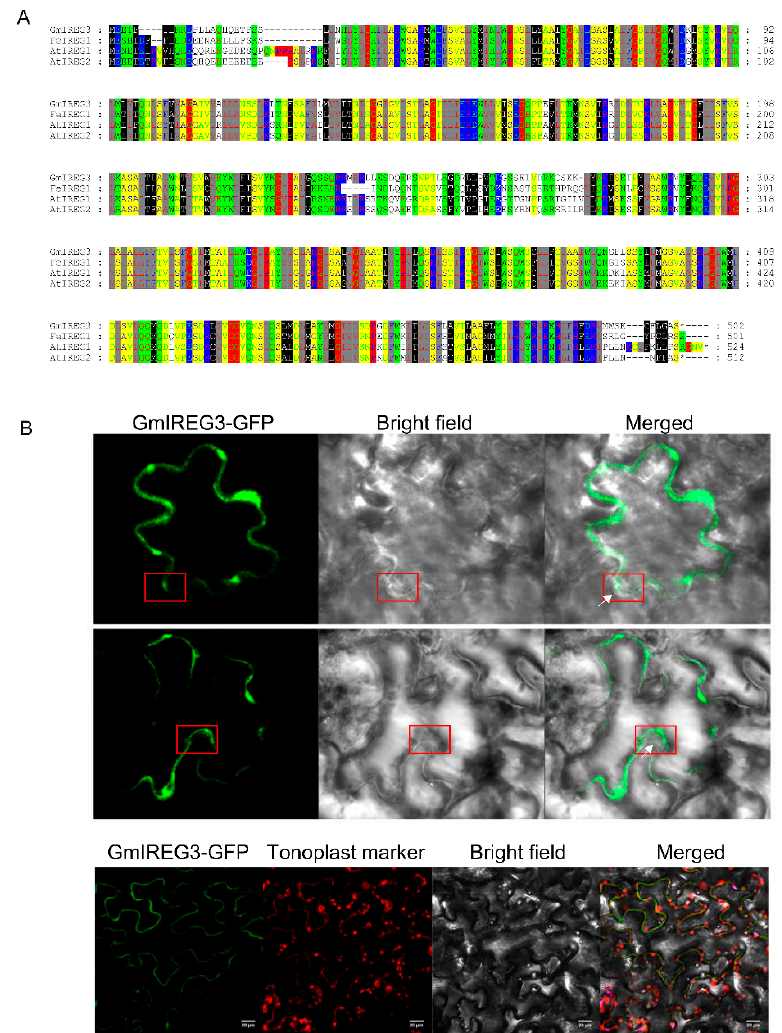
Figure 3. Alignment of amino acid sequence and subcellular localization of GmIREG3. ( A ) Amino acid sequence alignment of IREG proteins from soybean (GmIREG3), buckwheat (FeIREG1) and Arabidopsis (AtIREG1 and AtIREG2). ( B ) Subcellular localization of a C-terminal GmIREG3-GFP fusion protein in Nicotiana benthamiana and the fusion protein was driven by 35S promoter. At 3 d after infiltration, the fluorescence signals were visualized by confocal microscopy. GmIREG3-GFP was colocated with the tonoplast marker to the tonoplast. Red rectangles indicate the tonoplast separated from the plasma membrane and white arrows indicate the plasma membrane.